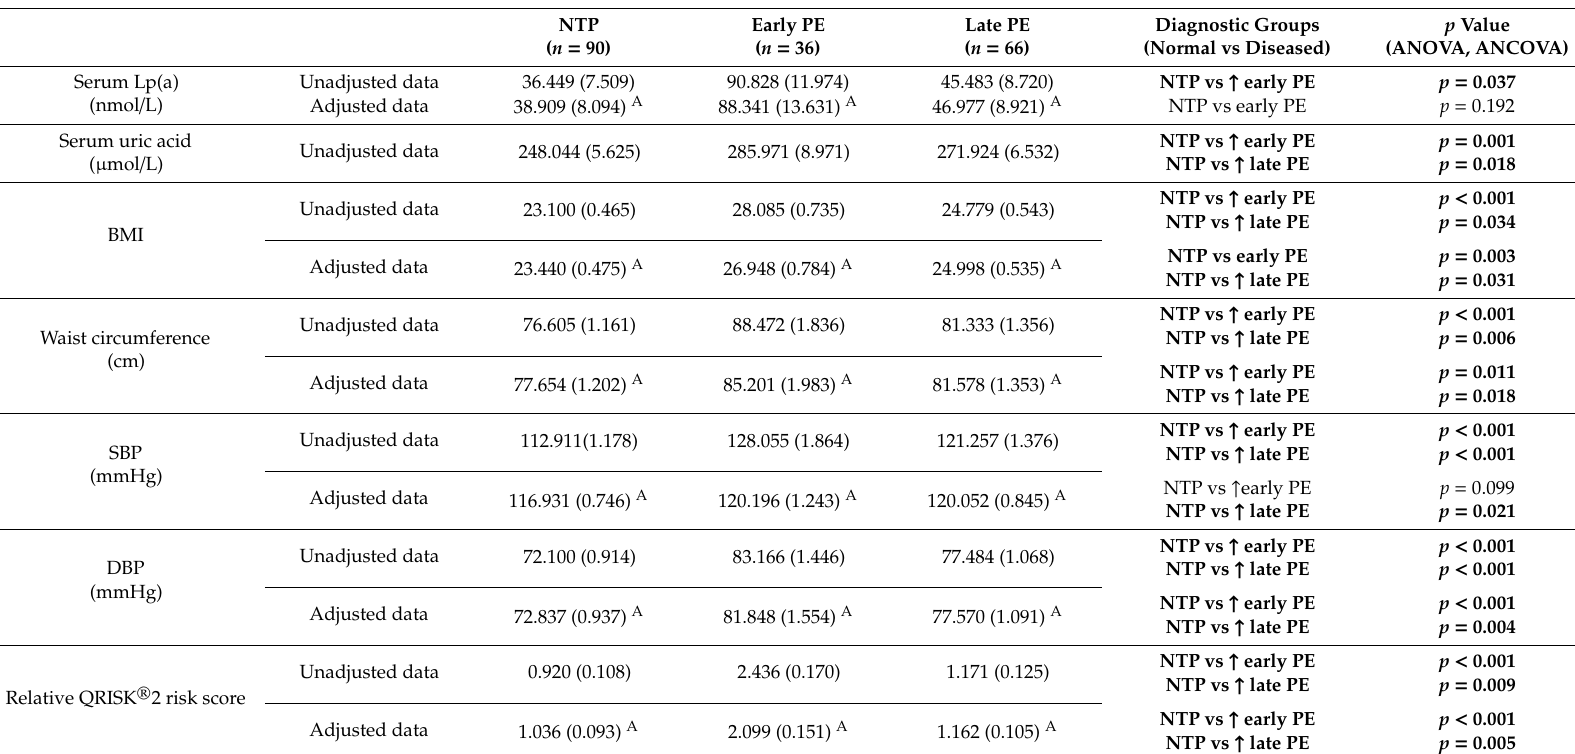
Table 6. Impact of PE with respect to delivery date on maternal cardiovascular risk - overview (ANOVA and ANCOVA analyses).